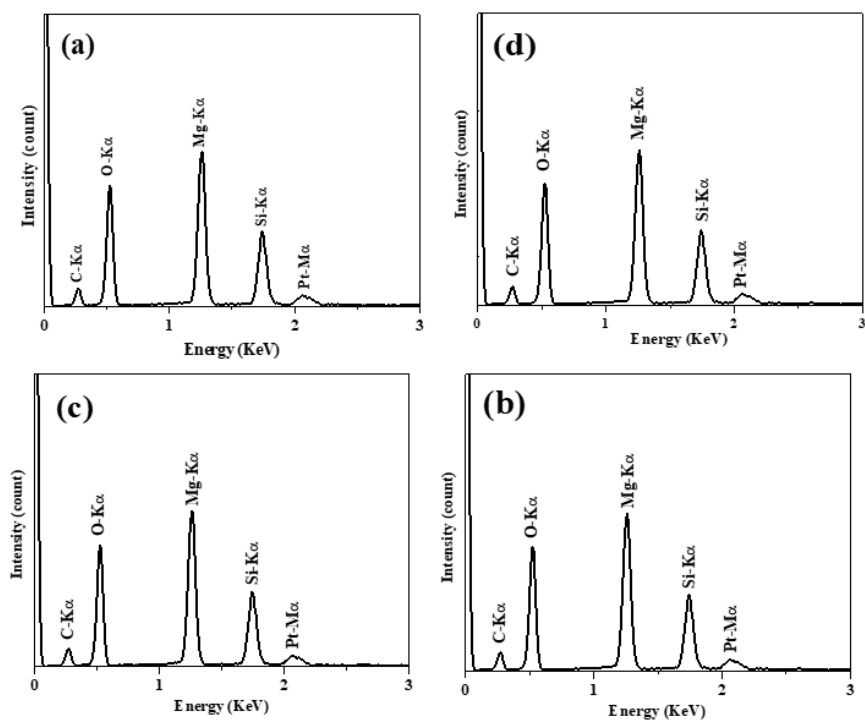
Figure 7. XEDS spectra of Mg 2 SiO 4 powders calcined at the temperatures of ( a ) 850, ( b ) 900, ( c ) 950, and ( d ) 1000 °C.